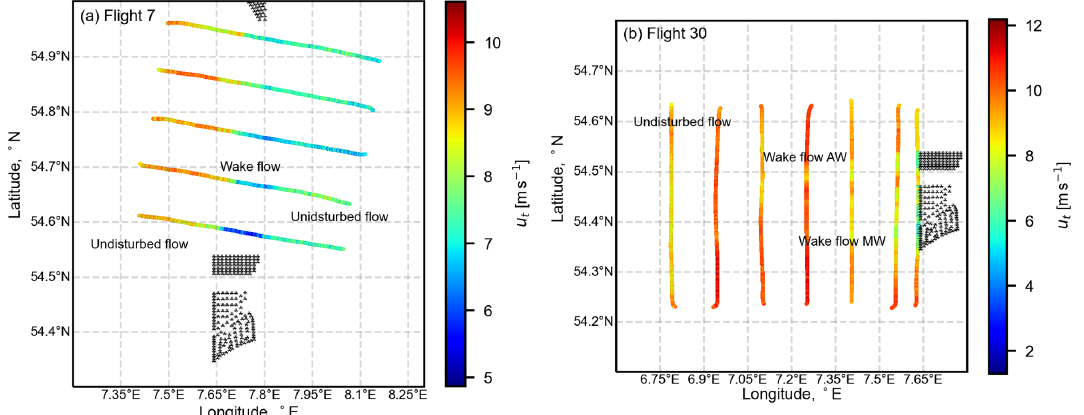
Figure 12. Downstream flight legs recorded during (a) flight 7 and (b) flight 30. The color bar shows variation in the horizontal wind speed component u t . The wake flow and undisturbed flow is annotated for both flights.